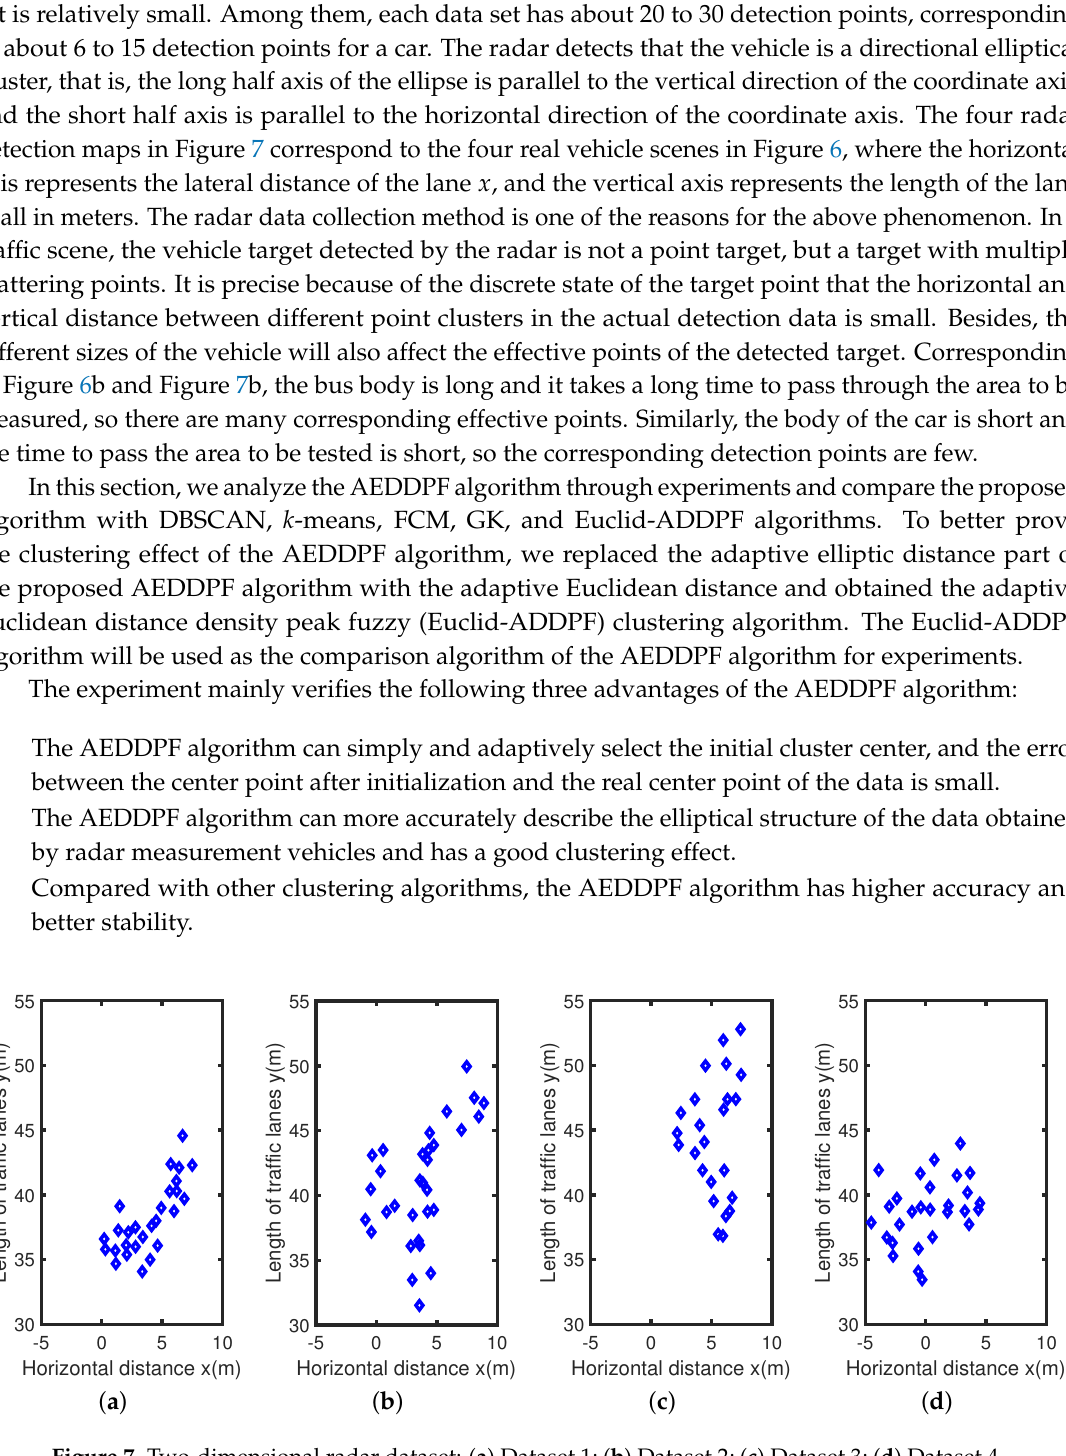
Figure 7. Two-dimensional radar dataset: ( a ) Dataset 1; ( b ) Dataset 2; ( c ) Dataset 3; ( d ) Dataset